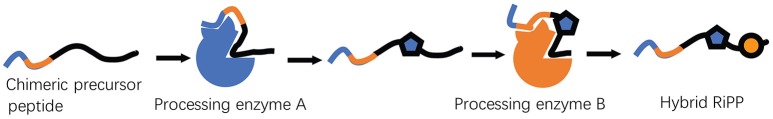
A chimeric leader peptide strategy to produce unnatural RiPP hybrids. By properly designing the concatenated leader peptides, recognition and processing by multiple enzymes from unrelated RiPP pathways could be realized. By using this method, a thiazoline-forming cyclodehydratase was combined with biosynthetic enzymes from the sactipeptide and lanthipeptide families to create new-to-nature hybrid RiPPs, demonstrating the feasibility of the strategy.